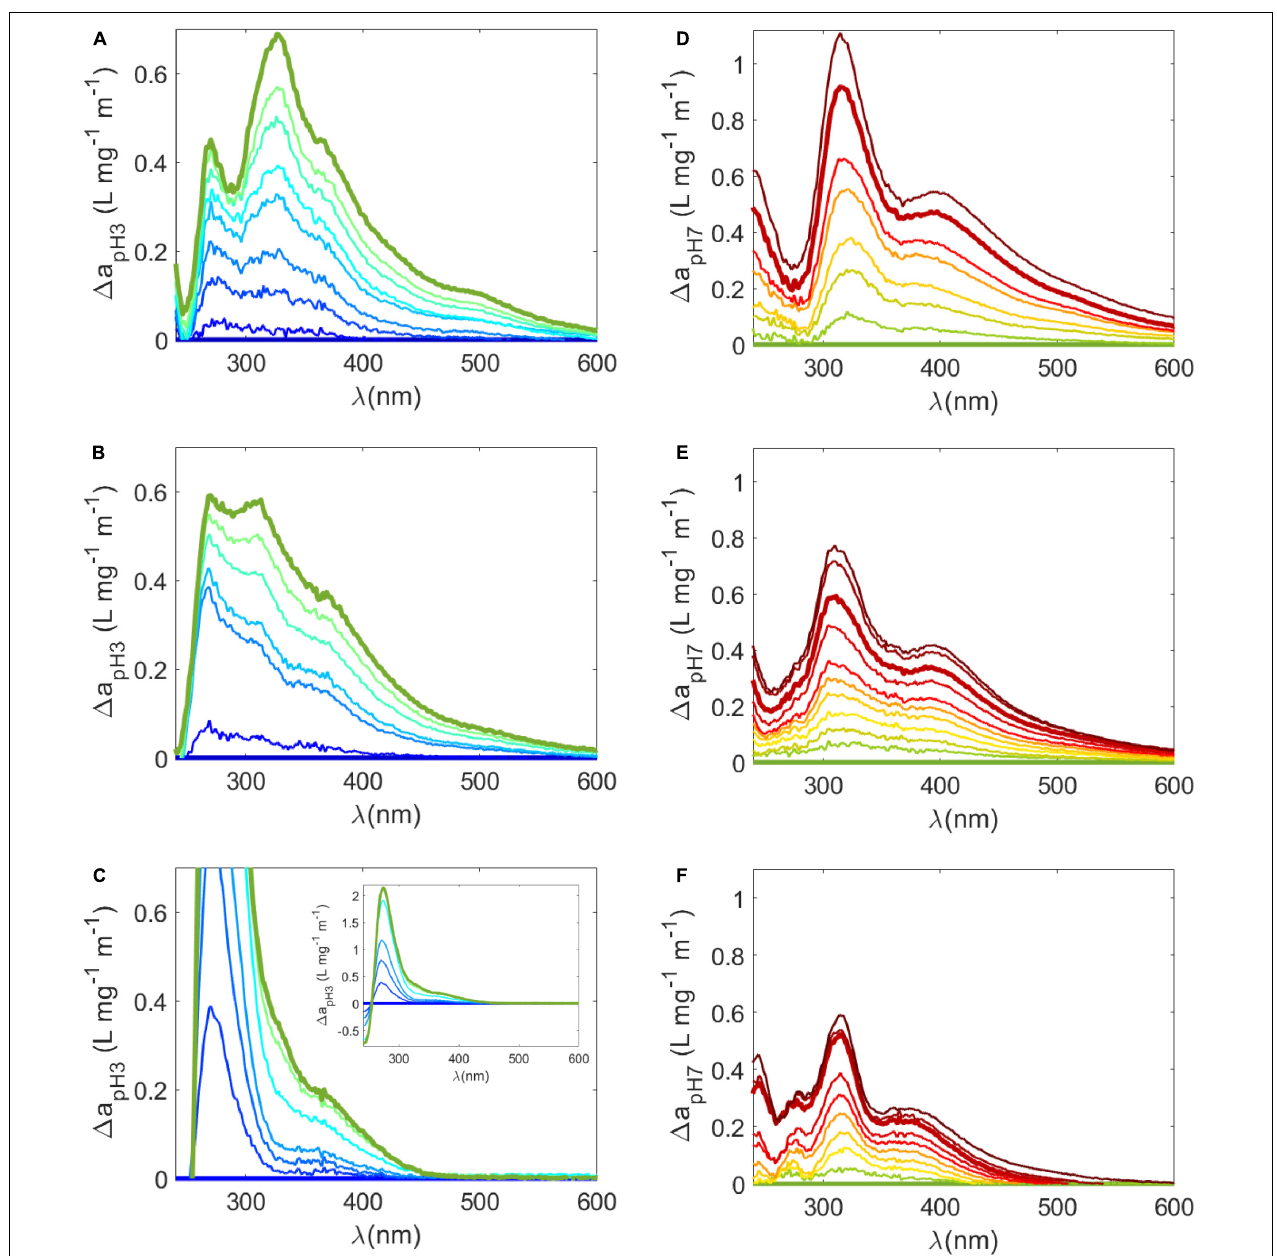
FIGURE 4 | (A–C) (cid:49) a ( λ ) (Eq 11) from pH 3 (i.e., change in mass normalized a ( λ ) determined by [ a ( λ ) pH – a ( λ ) pH 3 ]/DOC) where (A) is the untreated sample, (B) is the irradiated sample, and (C) is the reduced sample. Bold lines represent (cid:49) a ( λ ) at pH 3 (flat blue line) and pH 7 (light green line), meant to highlight the change in the carboxylic acid pKa range. (A–C) Are plotted on the same scale but the inset in (C) shows the entire (cid:49) a ( λ ) plot for the reduced sample. (D–F) (cid:49) a ( λ ) from pH 7 where (D) is untreated, (E) is irradiated, and (F) is reduced. Bold lines represent (cid:49) a ( λ ) at pH 7 (flat light green line) to pH 10 (bold red line) to highlight the change in the phenolic pKa